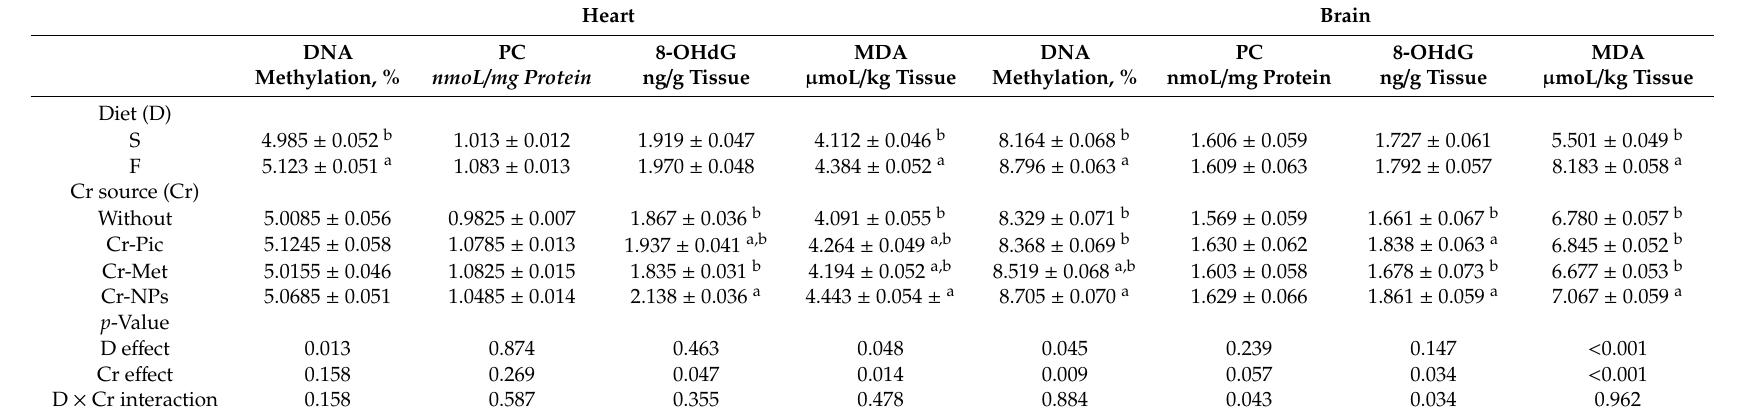
Table 2. DNA methylation and indicators of oxidative changes in the heart and brain tissue of rats. Heart Brain DNA PC 8-OHdG nmoL / mg Protein Methylation, % ng / g Tissue